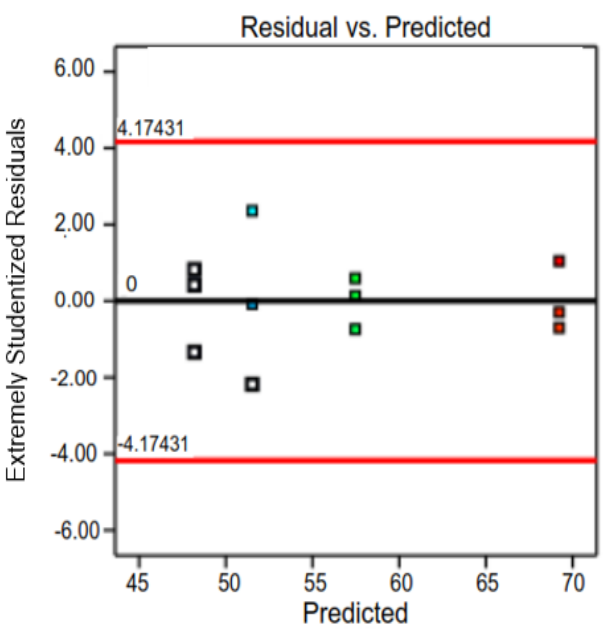
Figure 2. Residual vs. predicted analysis. Table 6. Report of the design